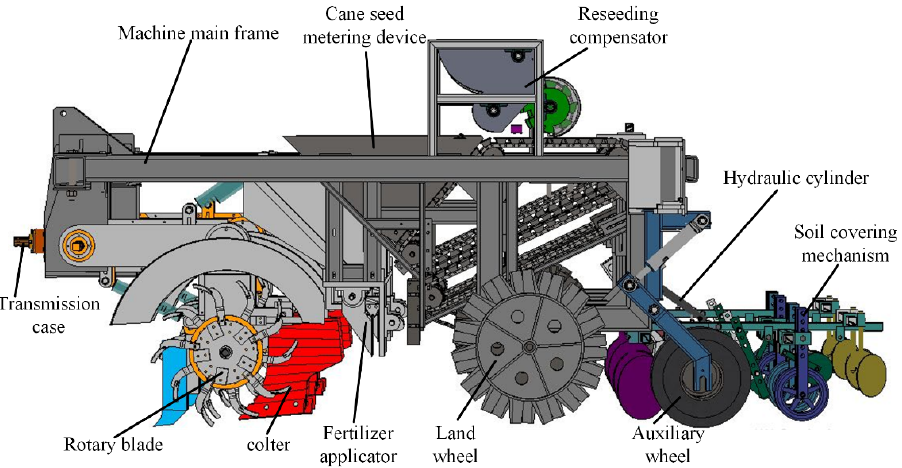
Figure 2. Overall structure of the transverse planter.